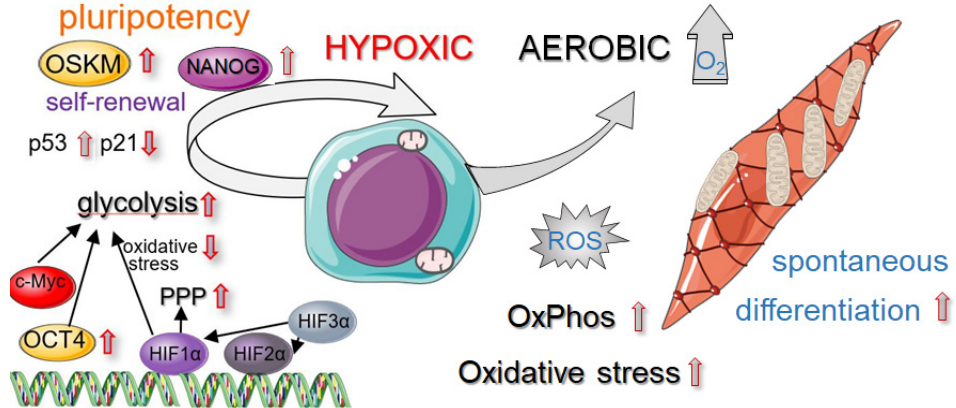
Figure 1. Basic aspects of pluripotent stem cell (PSC) biology. PSCs, which reside in hypoxic niches (3–5% O 2 ), maintain pluripotency and self-renewal capacity. Atmospheric oxygen level (21% O 2 ) may increase mitochondrial OxPhos with higher ROS production and increased spontaneous differentiation. Abbreviations: OKSM—Yamanaka’s factors: OCT4, KLF4, SOX2, c-MYC; HIF—hypoxia-inducible factor; OxPhos—oxidative phosphorylation; PPP—pentose phosphate pathway; ROS—reactive oxygen species.